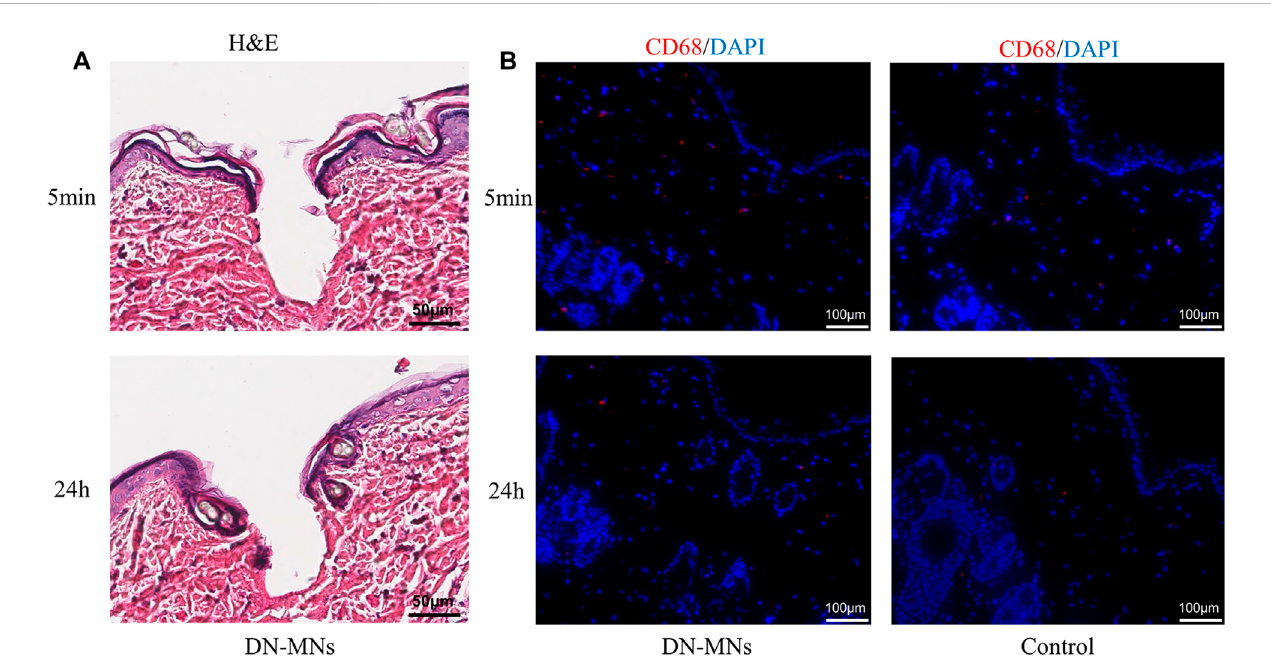
FIGURE 7 In vivo biocompatibility of DN MNs. (A) H&E staining of skin tissues after DN MNs application at 5 min and 24 h post-implantation. (B) Immuno- histological staining of immune cells in the